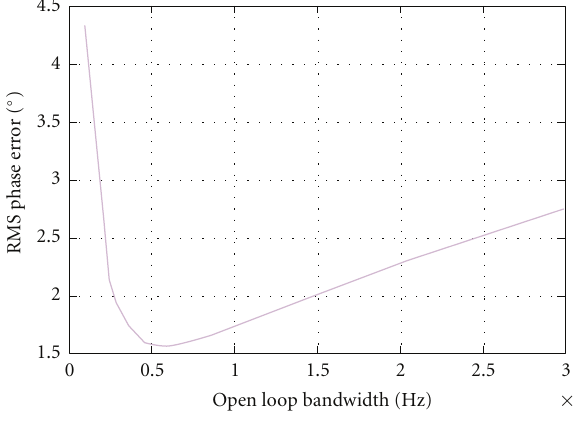
Figure 13: Integrated RMS phase error.